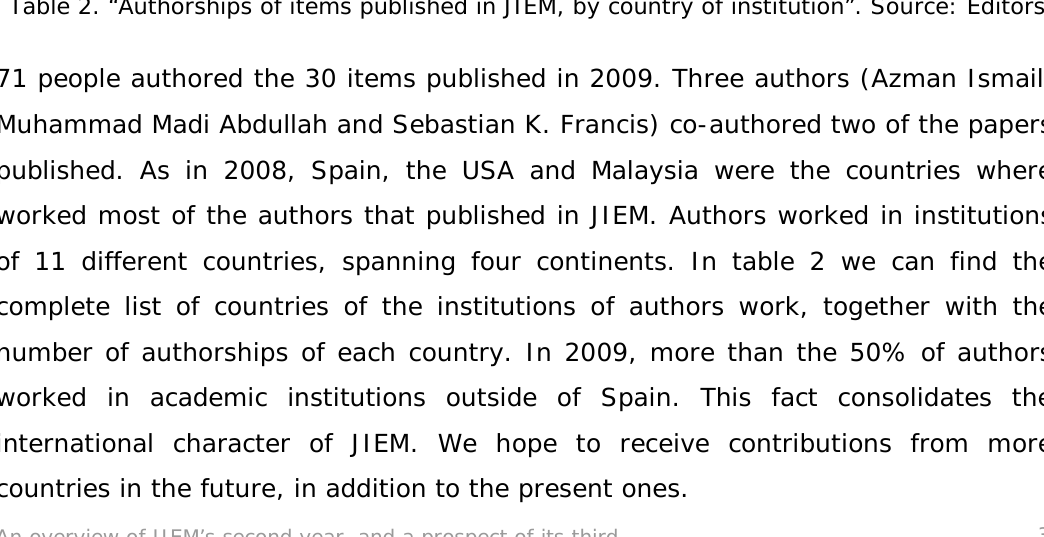
Table 2. “Authorships of items published in JIEM, by country of institution”. Source: